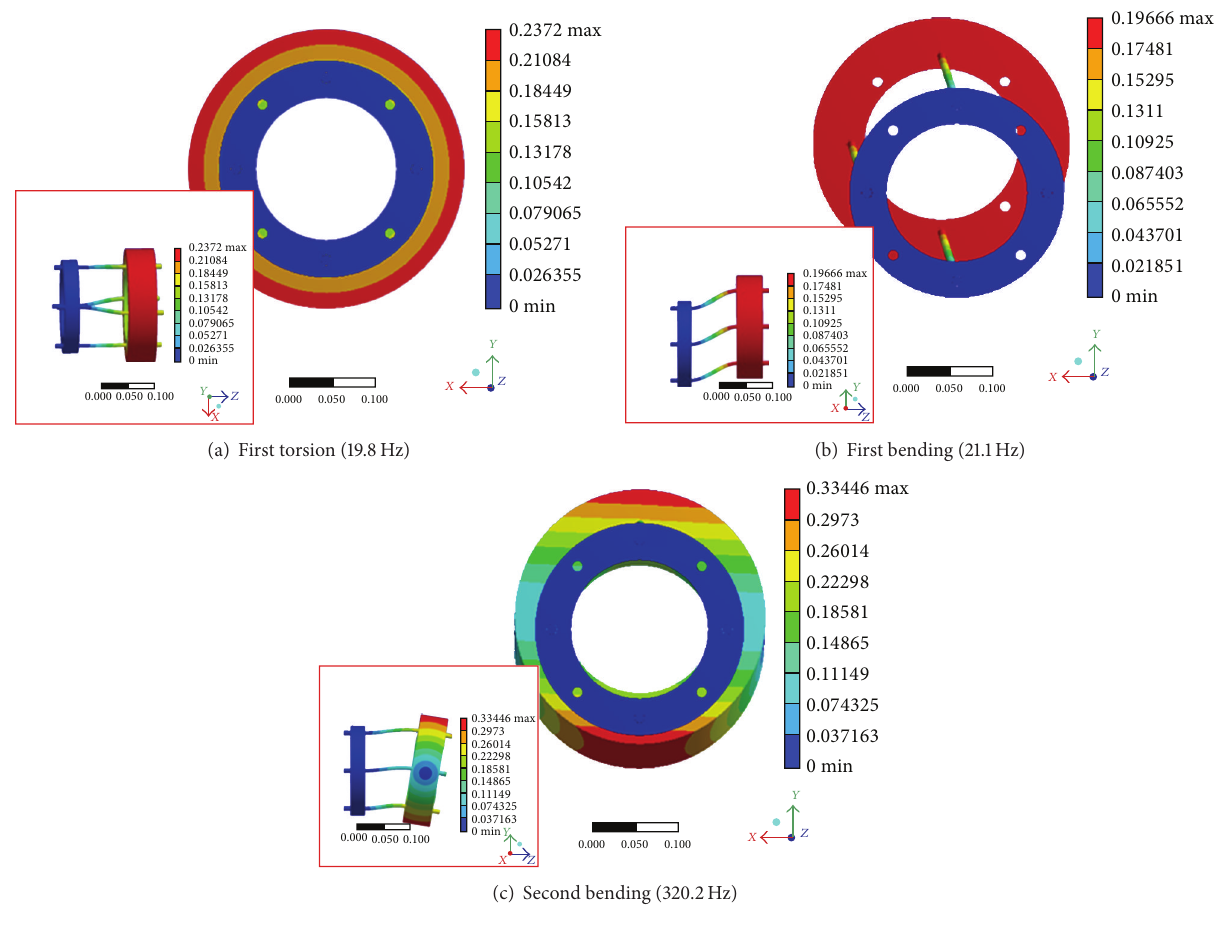
Figure 6: Natural modes of